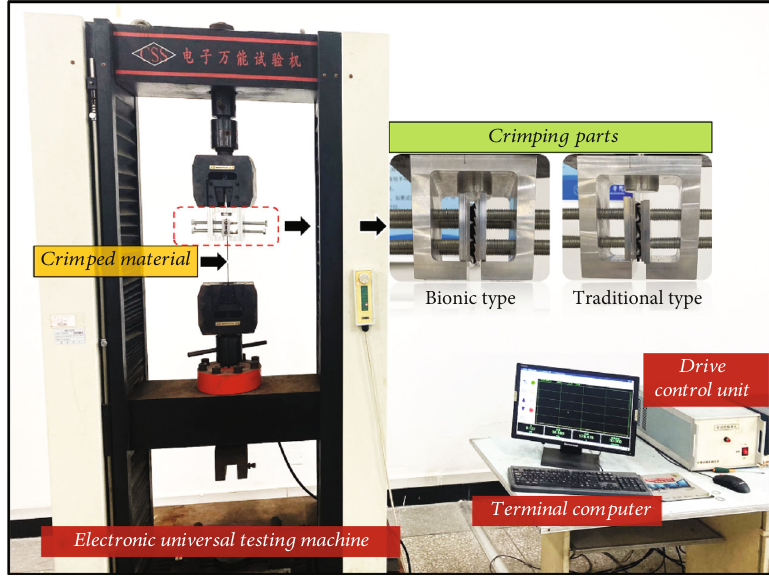
Figure 8: Tensile test platform for crimped material.